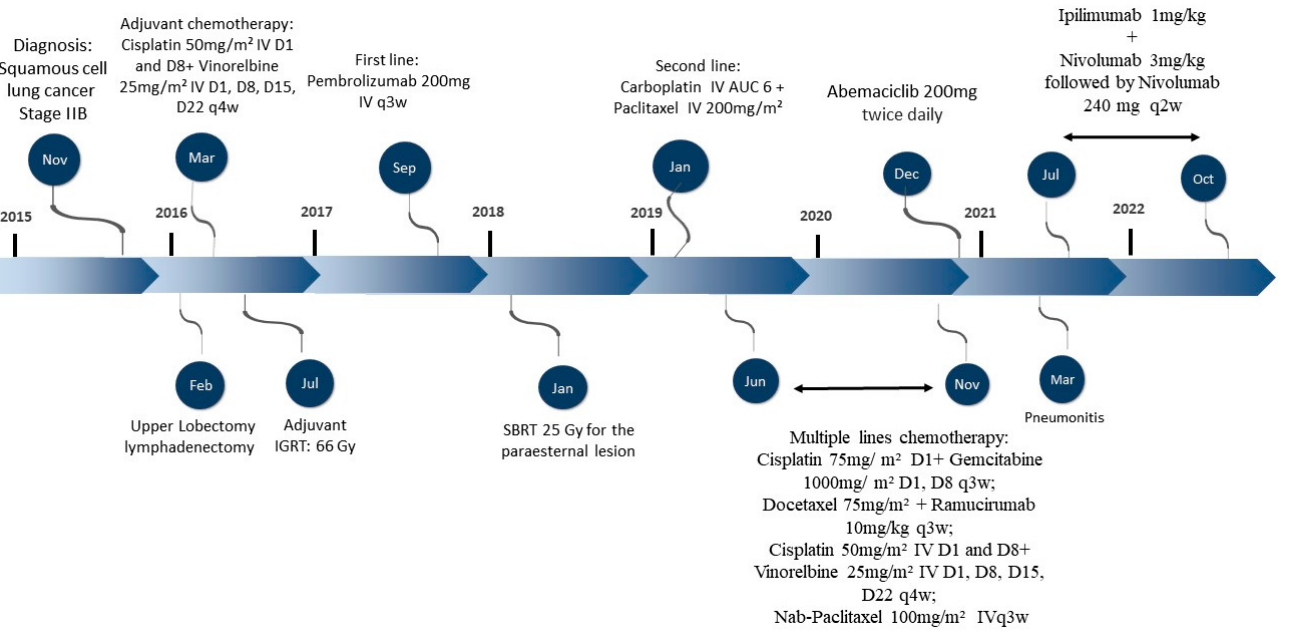
Figure 1. Overview of the patient’s course of disease and treatment regimens.